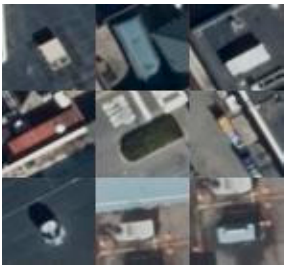
Figure 6. Instances of hard example patches.